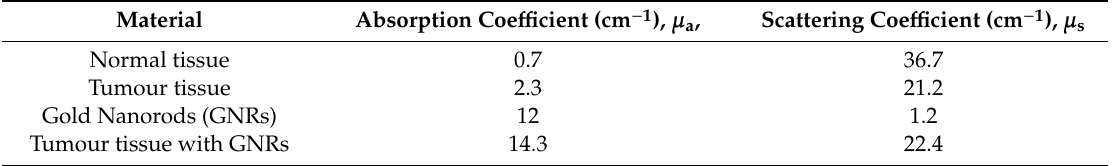
Table 1. Absorbance, µ a , and Scattering, µ s , values used in the